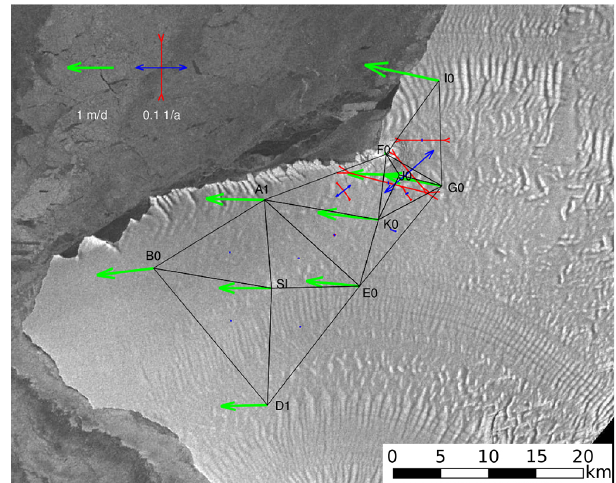
Fig. 12. Locations of the BIS real time GPS network in 2011. Dur- ing the 2011/2012 season this network was moved to surround the Halley VI base.